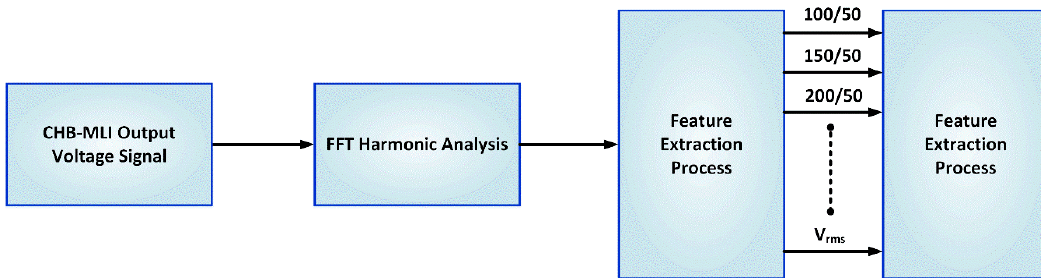
Figure 6. LabVIEW based fault investigative system using FFT features.